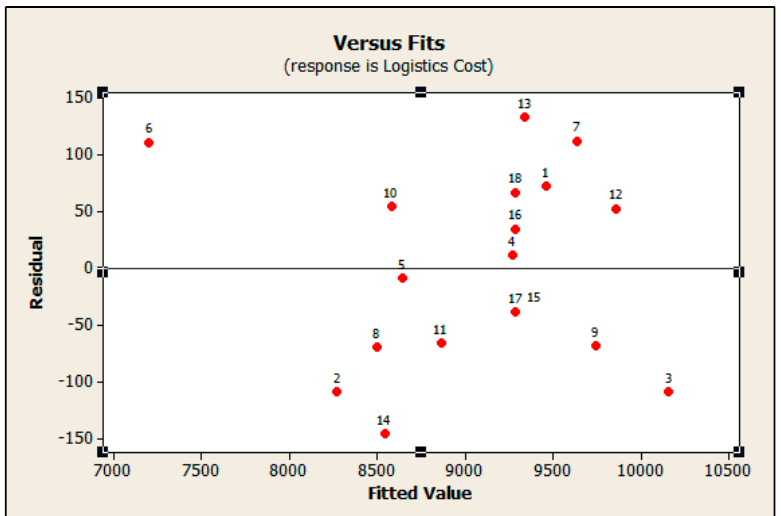
Figure 3. Residuals Normal Probability Plot for Logistic Cost.